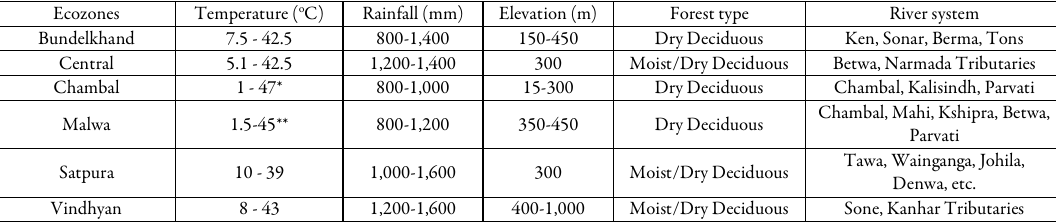
Figure 1. Location of the study area: Central India (Madhya Pradesh) with major Landcover; forest, agriculture and water bodies, on the left and numeric distribution of vultures in different districts, on the right. Inset gives relative position of the study area in India Table 1. Climatic and physiographic characteristics of ecozones in the study